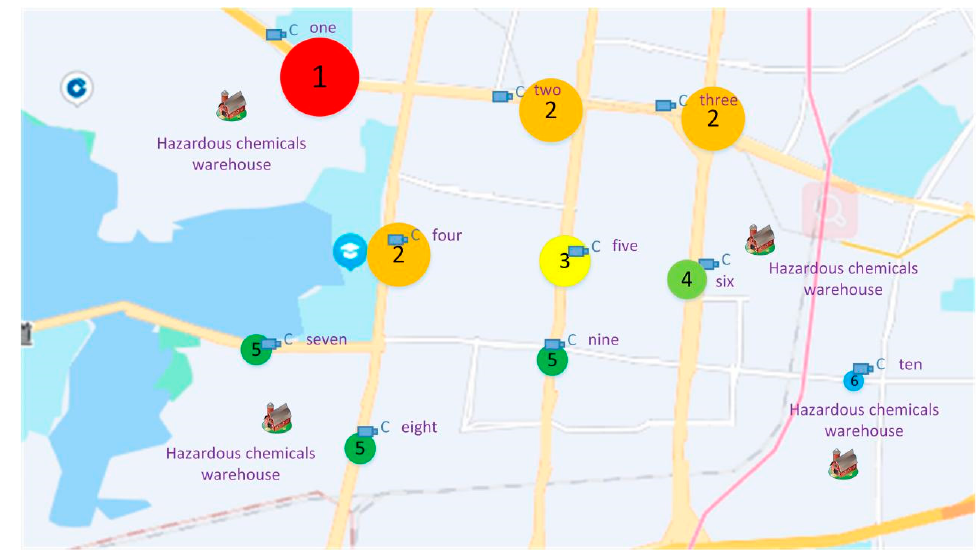
Figure 12. Different risk levels of different locations. Figure 12 depicts the different risk levels of different locations. The size of the circle on location one is the largest, and the color is red. It is visible that location one is the high- est risk level affected by hazardous goods. The reason is that all the hazardous goods ve- hicles need to pass through position 1. Locations two, three, and four have the same risk level of 2. This is followed by position three, with a risk level of 3 and a circle size smaller than position one, two, three, and four, colored yellow. The risk level of position six is 4. The risk level of position seven is the same as position eight and nine. The risk level of